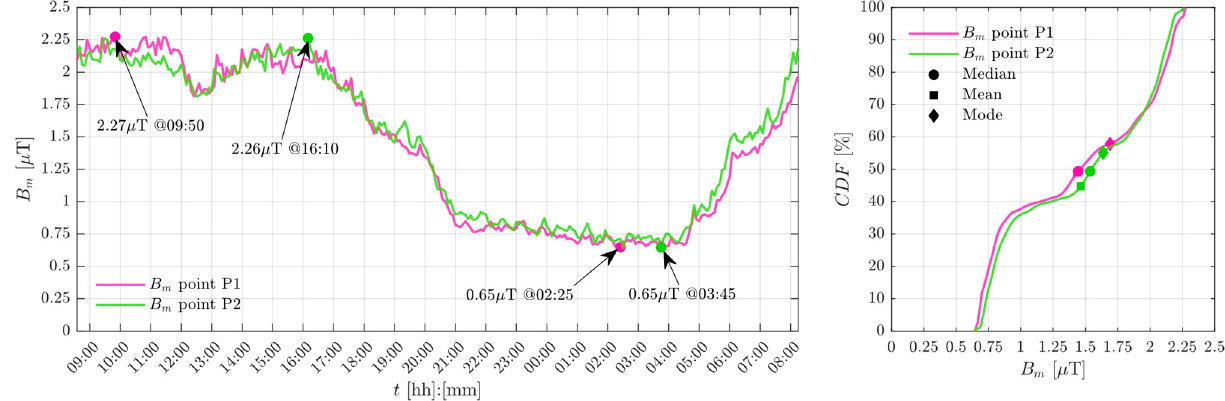
Table 1. Measured field statistics and information for points P1 and P2.